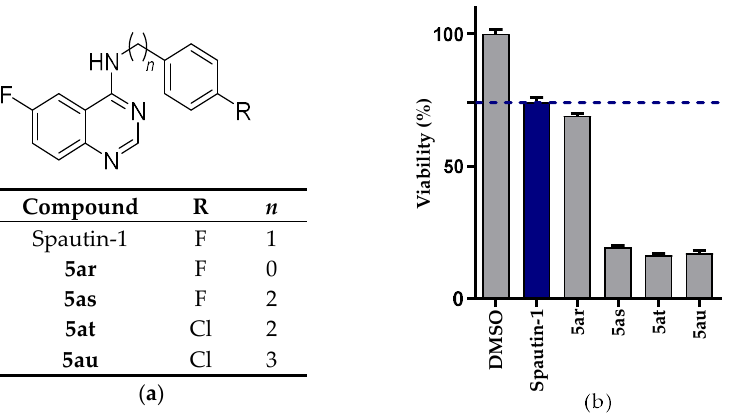
Figure 7. ( a ) Influence of the chain length; ( b ) viability assay (5µM) with Spautin-1 as reference. Despite the fact that analogues with n = 0 might act as EGFR TKIs, a small series of analogues was tested (Figure 8). Remarkably, a fluorine at the 3’ or 2’ position ( 5av , 5aw ) of the phenyl group significantly improved the activity as compared to the fluorine at the 4’ position 5ar . Moreover, for n = 1, a fluorine substituent at the 2’ position also gave the best result (Figure 4, 5ae ). However, in the n = 1 series, a fluorine at the 3’ position resulted in a less active compound, as compared to Spautin-1, which indicates that a fluorine in proximity of the quinazoline core is beneficial. An electron-donating group at position R 1 , on the other hand, providing 5ay , resulted in a weaker reduction in tumor cell viability as compared to 5av . Remarkably, a phenyl group at the 3’ position of the phenyl group 13a was allowed while the 1-hydroxy-3-butynyl group 14a completely abolished the activity.